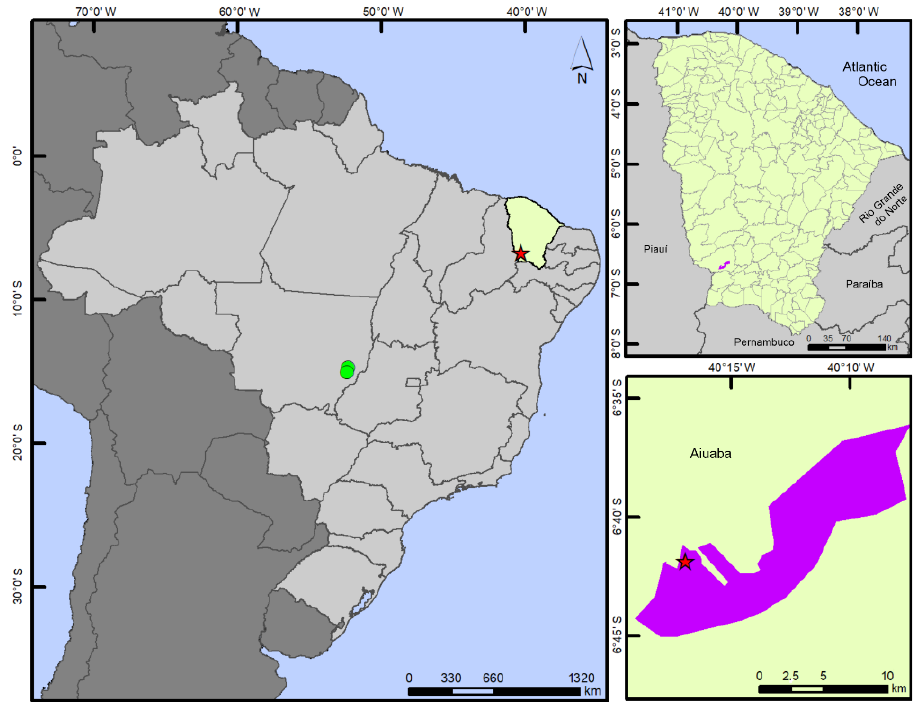
Figure 7. Geographic distribution of P. bilobata . Green circles show the previous records in Mato